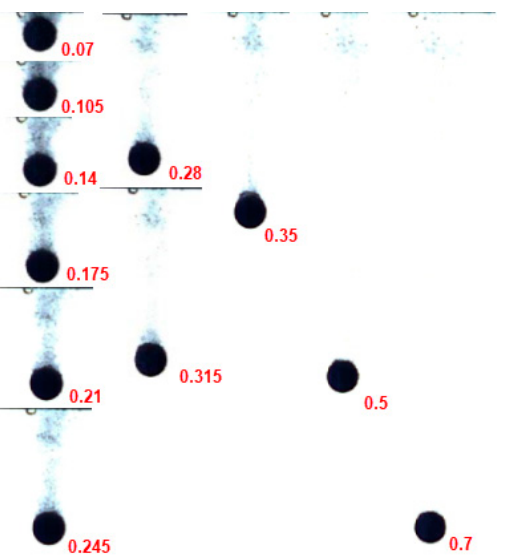
Figure 6. Vapor film around falling sphere with 300 °C at different non-dimensional time.